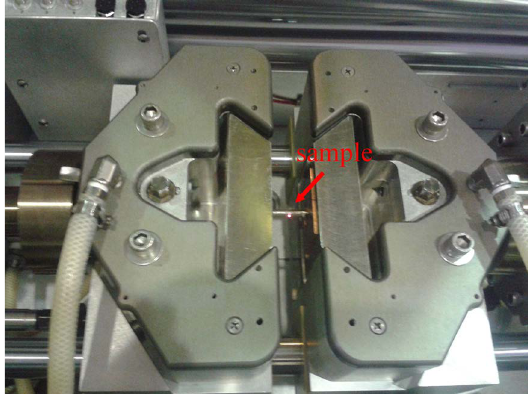
Figure 2. Photograph of the sample fixed inside the Gleeble for the XRD